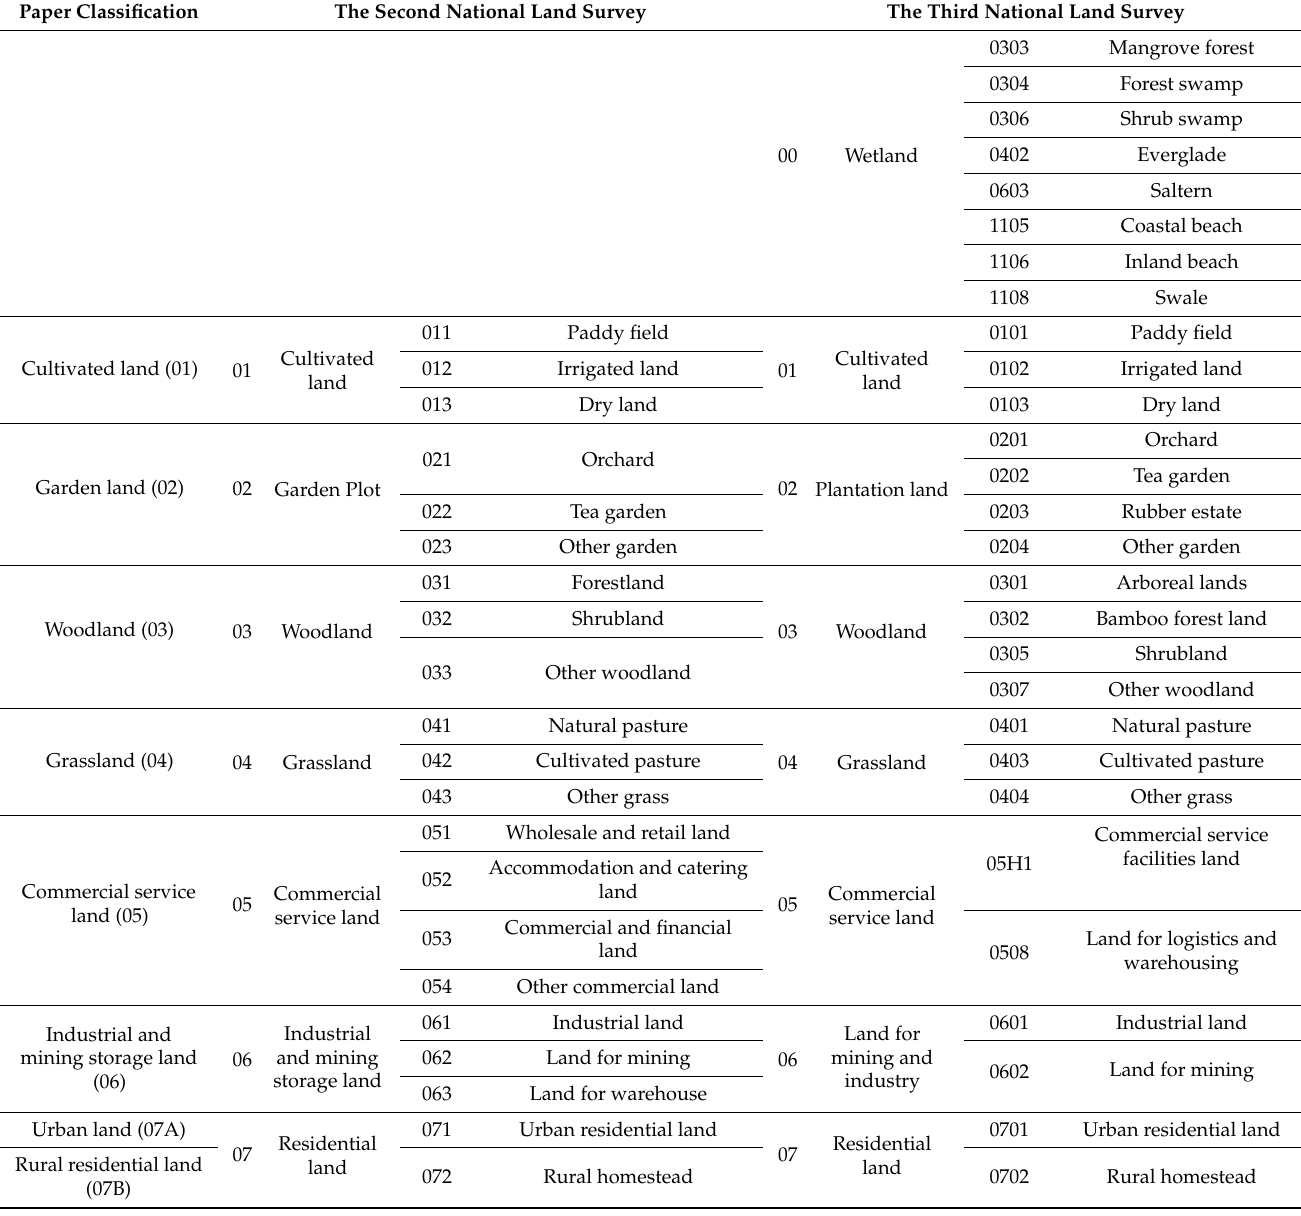
Table A2. Comparison of classified categories for China’s second and third land-use survey